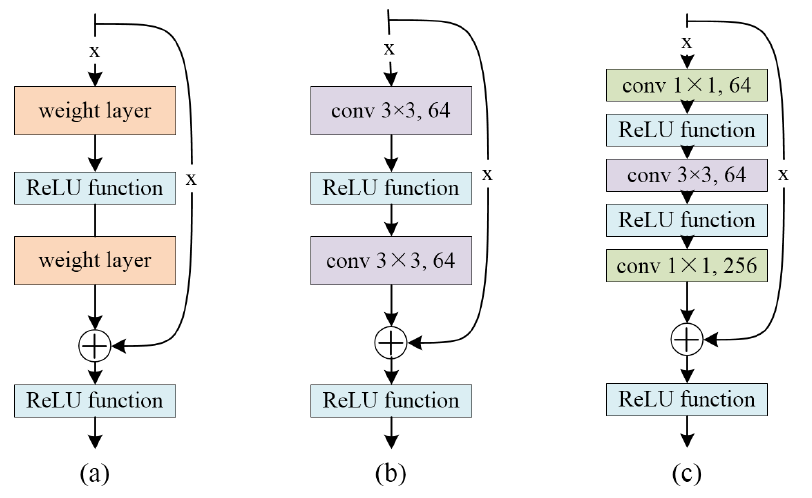
Figure 4. Structure of a building block in ResNet and two examples of a basic block for ResNet constructions of different depths [49]. ( a ) The basic structure with a shortcut for ResNet. ( b ) An example of a basic block used to build a shallow ResNet. ( c ) The “bottleneck” used to construct a deep ResNet by